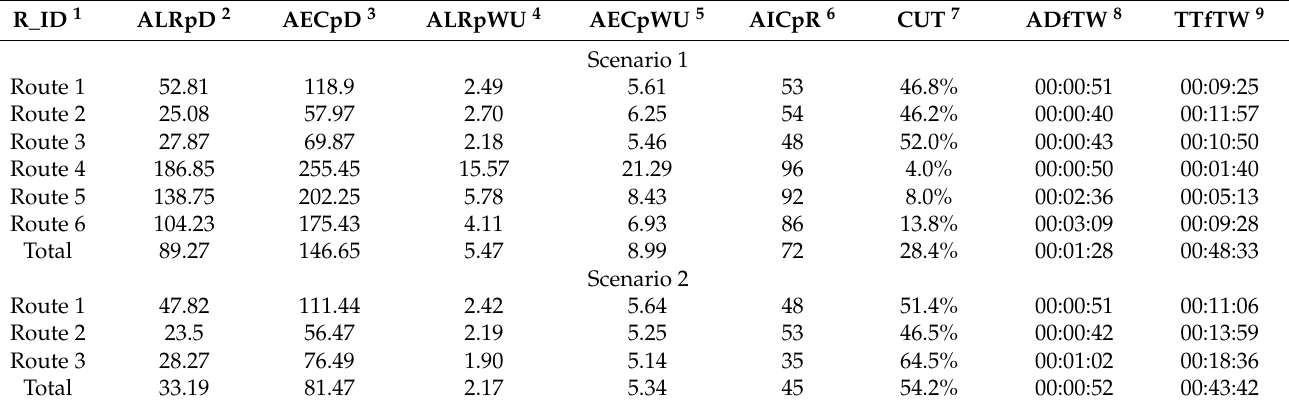
Table 12. Comparison of the computational results of conventional and I4.0 technologies supported milk-run-based in-plant supply optimization in the case of MES data-based and real-time supply